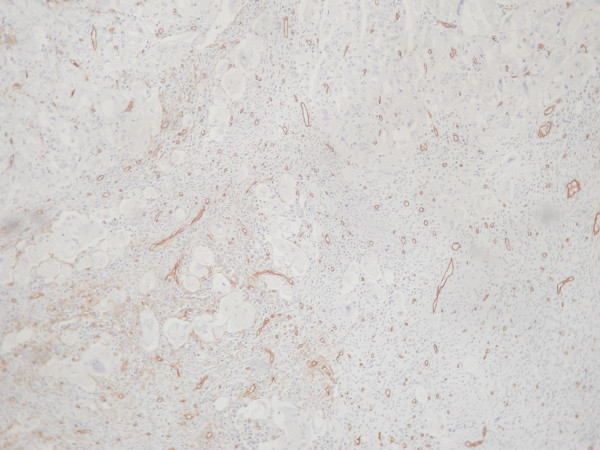
High-density of neoplastic vessels highlighted by stained anti-CD34 antibody in a case of a poorly differentiated adenocarcinoma of unknown primary (Original magnification 200, counterstained with hematoxylin).